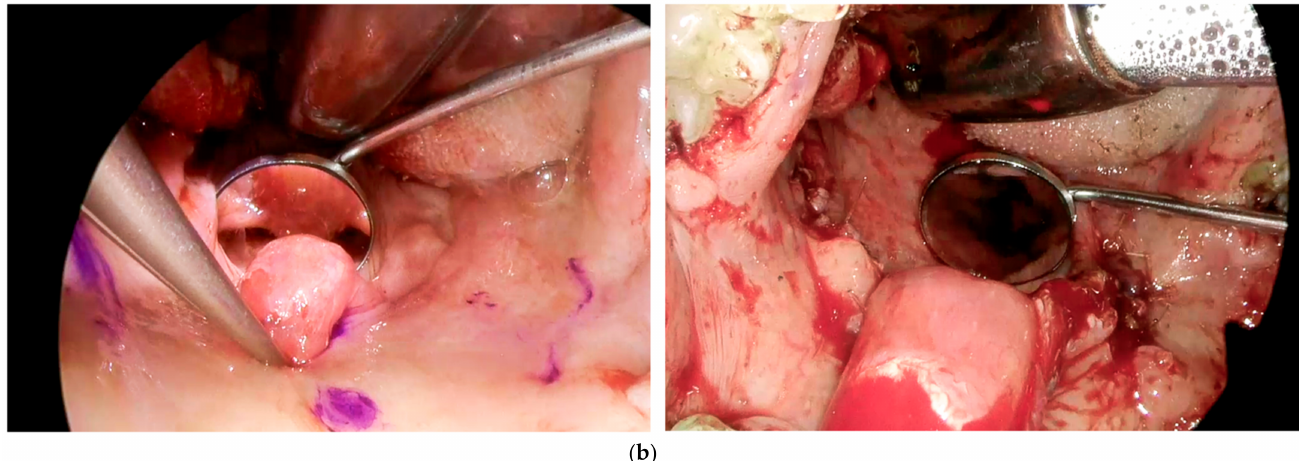
Figure 1. ( a ) Endoscopic view. 1: Surgery site with markings at the left and right pterygomandibular raphes, the base of the uvula and the hard palate; 2: palatal tonsils removed and ventral palate triangles of mucosa removed; 3: supratonsillar fat tissue removed and palatopharyngeus muscle dissected from the superior constrictor muscle; 4: dorsal palatal flaps rotated; left flap sutured in place and right flap prepared for suturing and 5: bilateral suturing of the dorsal flaps. ( b ) On the left: the retropalatal space before the surgery and the assessment of the length of the uvula for excising the tip. On the right: a significantly increased retropalatal space after the surgery and a view after removal of the enlarged